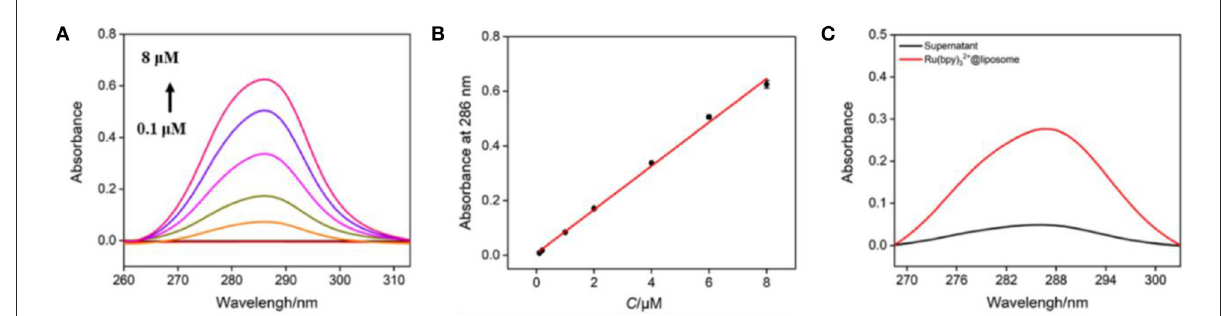
FIGURE4 (A) UV absorption spectra of different concentrations of Ru(bpy) 32 + (from bottom to up, 0.1 µ M, 0.2 µ M, 1 µ M, 2 µ M, 4 µ M, 6 µ M, 8 µ M). (B) The linear regression curve of absorbance vs. the concentration of Ru(bpy) 32 + . (C) UV absorption spectra of Ru(bpy) 32 + @liposome (diluted with PBS for 200 times) and the supernatant (diluted with PBS for 40 times) obtained after centrifugation.